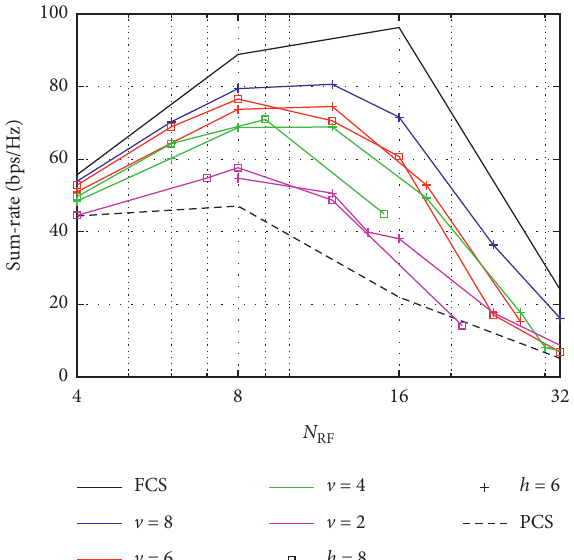
Figure 12: Sum-rate performance of various subarray